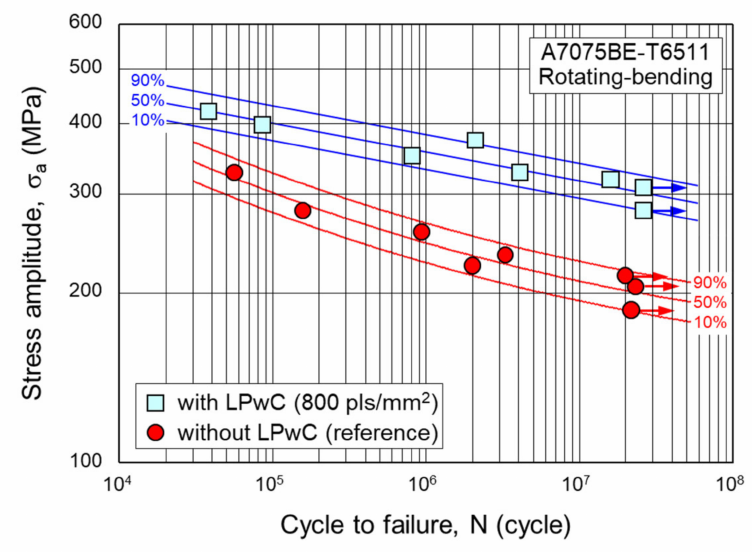
Figure 7. Fatigue test results of A7075BE-T6511 with and without